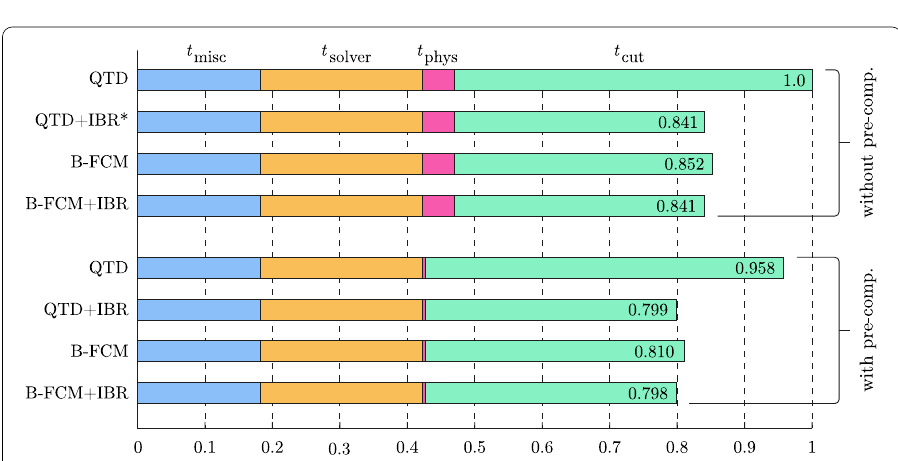
Fig. 29 Time compression ratios τ for the entire processing step. The times t phys and t cut refer to the times spent on the computation of the physical and cut cells, while t solver denotes the time needed for the solution of the eigenvalue problem. Furthermore, the time t misc includes miscellaneous tasks, such as the initialization of the code and assembling of the global matrices,